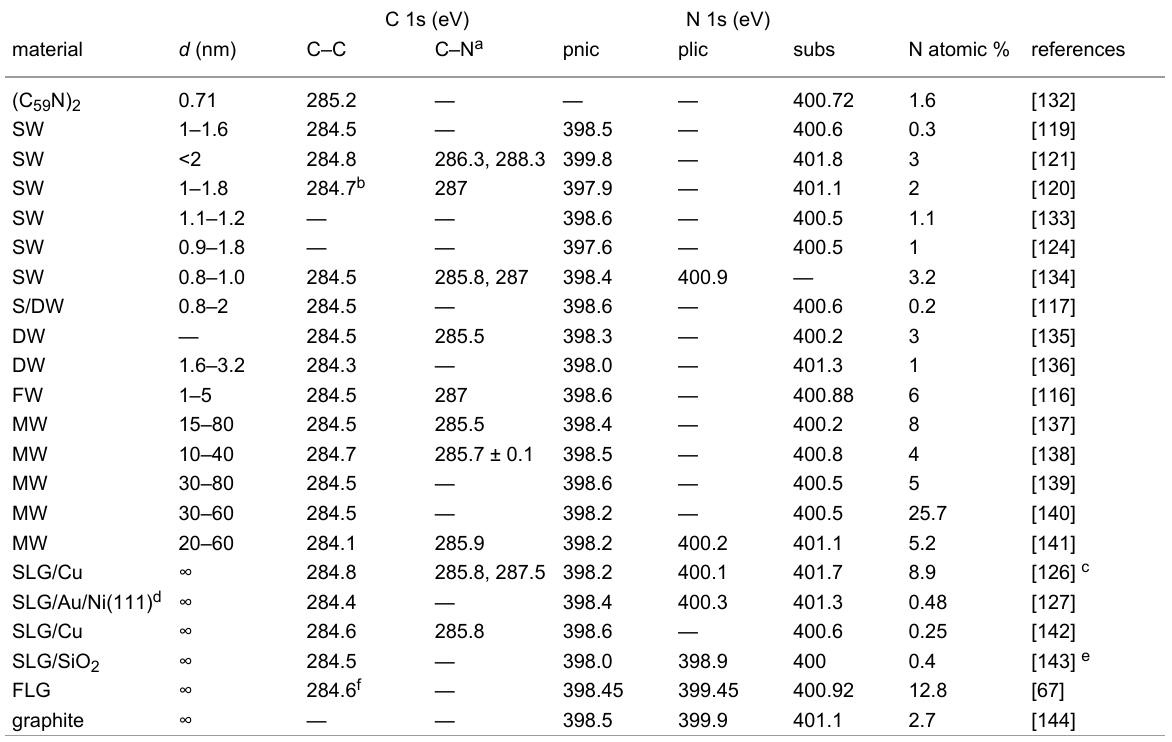
Table 2: XPS measurements of the carbon 1s and nitrogen 1s lines for various nitrogen-doped graphitic carbon nanomaterials reported in the litera- ture. The columns show the material, diameter of the nanostructure, the carbon 1s energy assigned to C–C bonds, and to C–N bonds, the nitrogen 1s energies assigned to pyridinic (pnic), pyrrolic (plic) and substitutional (subs) nitrogen, the concentration of nitrogen in atomic percent, and the citation for each measurement. C 1s (eV) N 1s